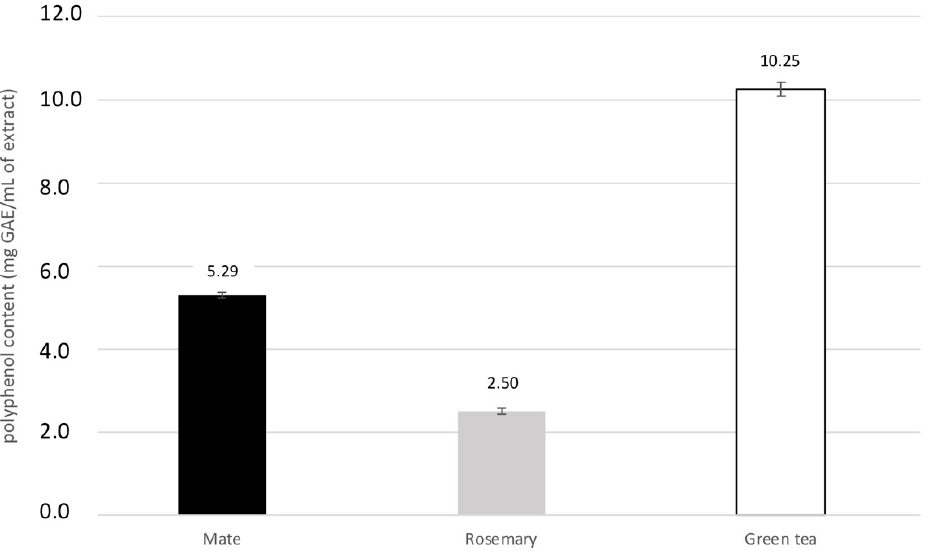
Figure 2. Polyphenol content of acetone–water (1:1) extract from mate (black bar), rosemary (grey bar) and green tea (white bar). Mean +/ − SD of six replicates is shown, and the results are expressed in mg GAE/mL of extract.